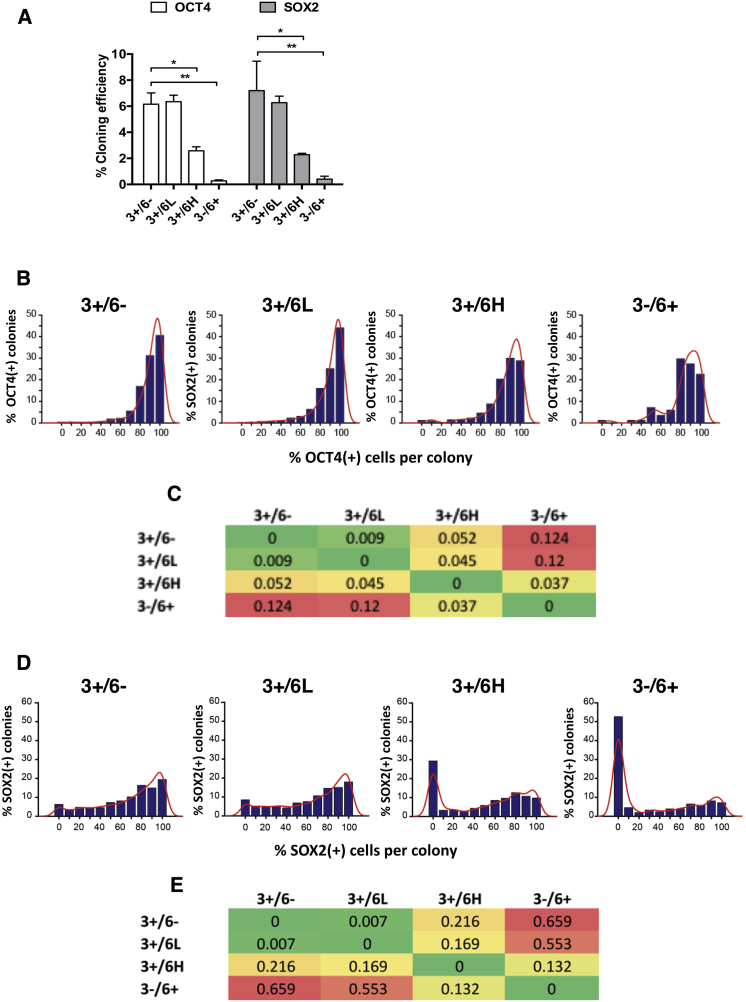
High GATA6 Expression Results in a Reduced Cloning Efficiency(A) Percentage cloning efficiency of each cell fraction (3+/6−, 3+/6L, 3+/6H, and 3−/6+) using OCT4 (left) and SOX2 (right) as markers for the stem cell state. Sorted fractions were plated as single cells at clonogenic density in KO/SR and MEF conditions. Cloning efficiency was calculated by dividing the number of OCT4-positive (left) or SOX2-positive (right) colonies by starting seed density. Error bars represent SD of three biological experiments. Student’s t test was used to determine significance (OCT4 graph: 3+/6− to 3+/6H *p = 0.0017, 3+/6− to 3−/6+ ∗∗p = 0.0001, SOX2 graph; 3+/6− to 3−/6H ∗p = 0.0019, 3+/6− to 3−/6+ ∗p = 0.0002).(B) Proportion of OCT4-positive (OCT4[+]) cells in OCT4-positive colonies derived from single cells from fractions 3+/6−, 3+/6L, 3+/6H, and 3−/6+. Positive colonies include one or more OCT4(+) cells. Counts are shown as bar plots (blue) with superimposed estimated nonparametric distribution (red).(C) Kullback-Leibler symmetric divergence between OCT4-associated distributions shown in (B). This measure increases with reduced similarity between distributions; zero indicates identical distributions.(D) Proportion of SOX2(+) (SOX2-positive) cells in SOX2-positive colonies derived from single cells from fractions 3+/6−, 3+/6L, 3+/6H, and 3−/6+. Positive colonies include one or more SOX2(+) cells. Counts are shown as bar plots (blue) with superimposed estimated nonparametric distribution (red).(E) Kullback-Leibler symmetric divergence between SOX2-associated distributions shown in (D).